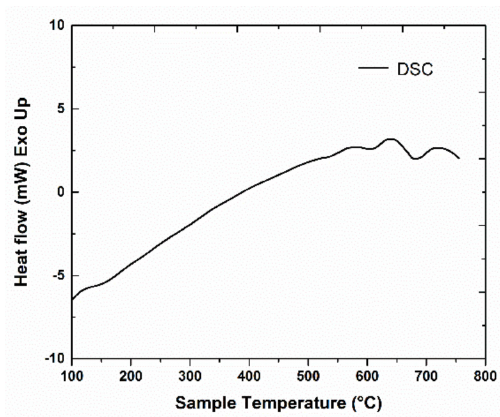
Figure 2. DSC scan for Mn 52 Al 46 C 2